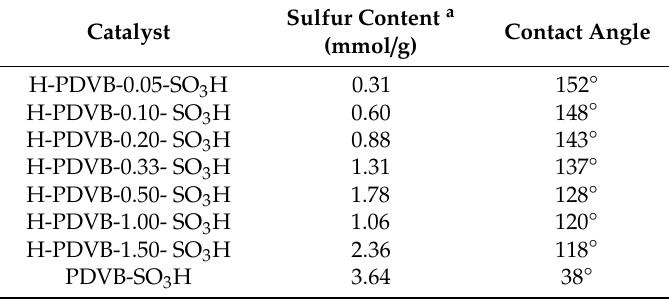
Table 4. Hydrophobicity related to sulfur content of sulfonic acid-based resins. a Determined by elemental analysis. Adapted from Reference [42].